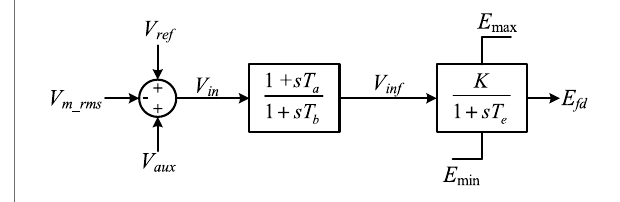
FIGURE 7 | SEXS exciter.